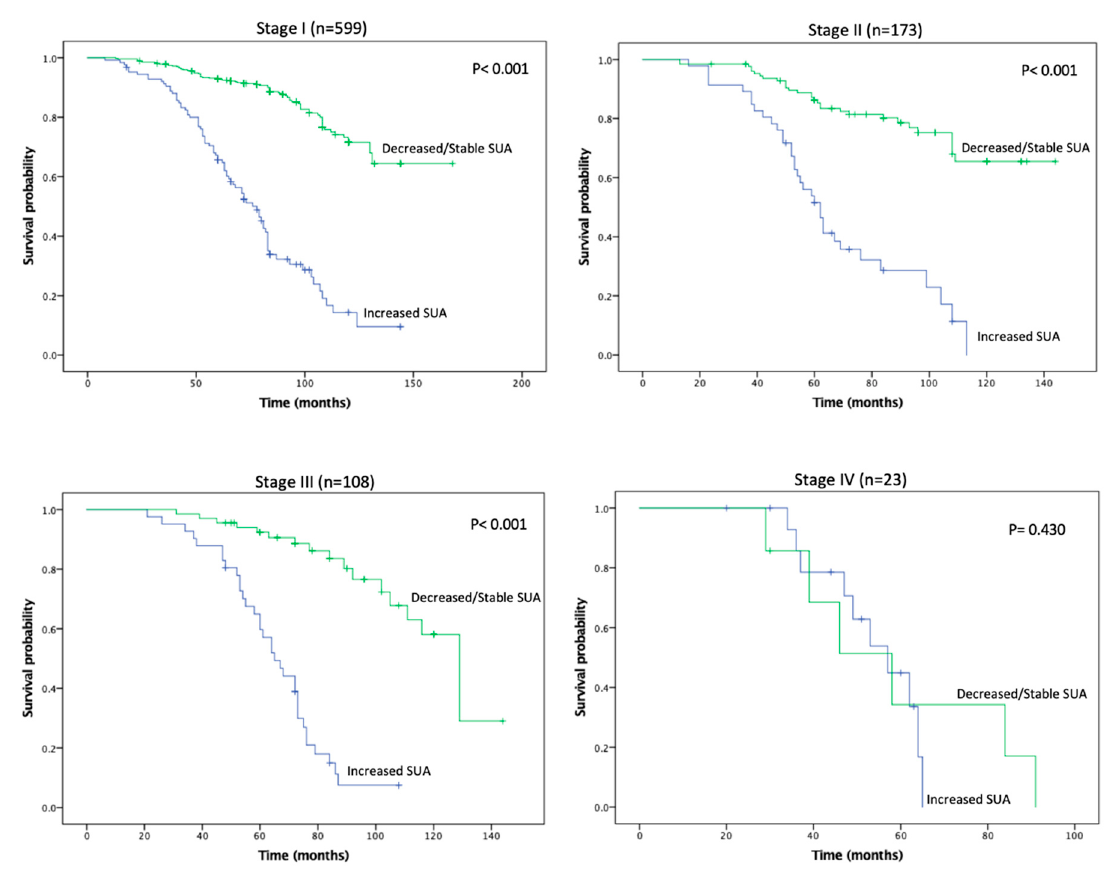
Figure 3. Kaplan-Meier plot for overall survival in the stable/decreased uric acid and increased uric acid groups, separated by disease stage.